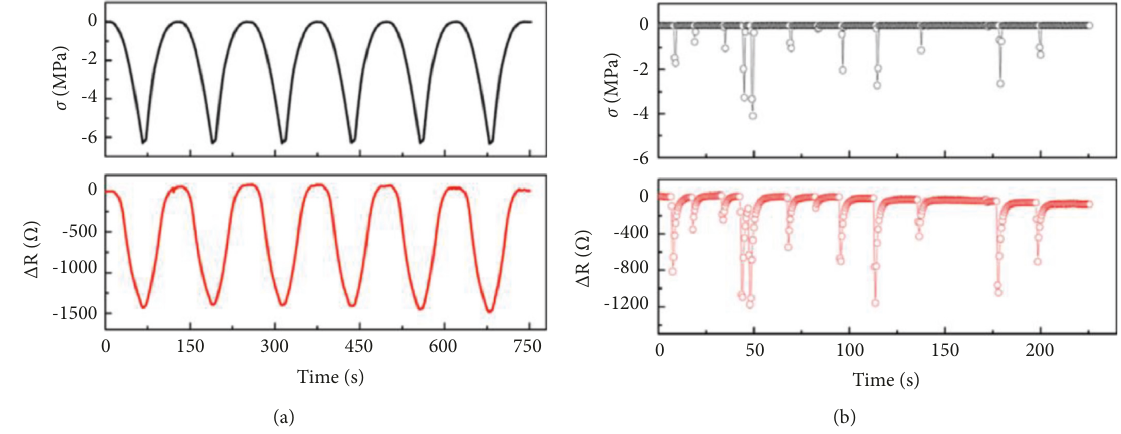
Figure 20: Relationships between compressive stress and resistance for the self-sensing CNTC: (a) under repeated compressive loading; (b) under impulsive loading [106].